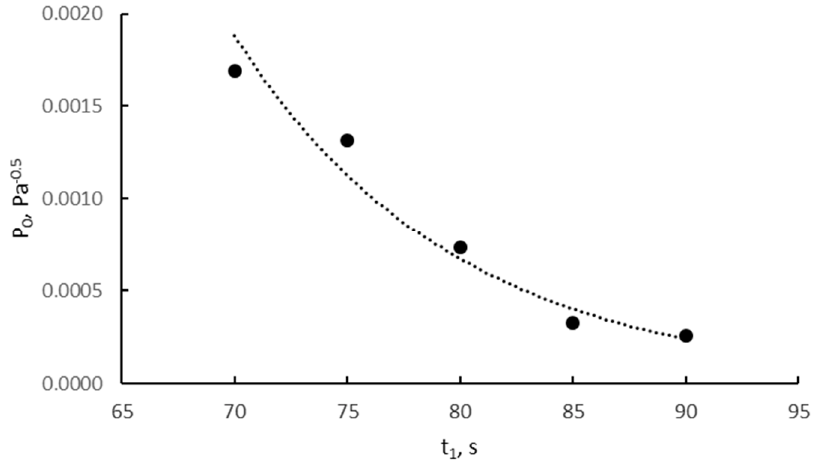
Figure 2. The minimum nitriding potential at which the nitriding of the smallest iron nanocrystallites begins in the samples reduced and heated in hydrogen in the temperature range of 500–700 °C.